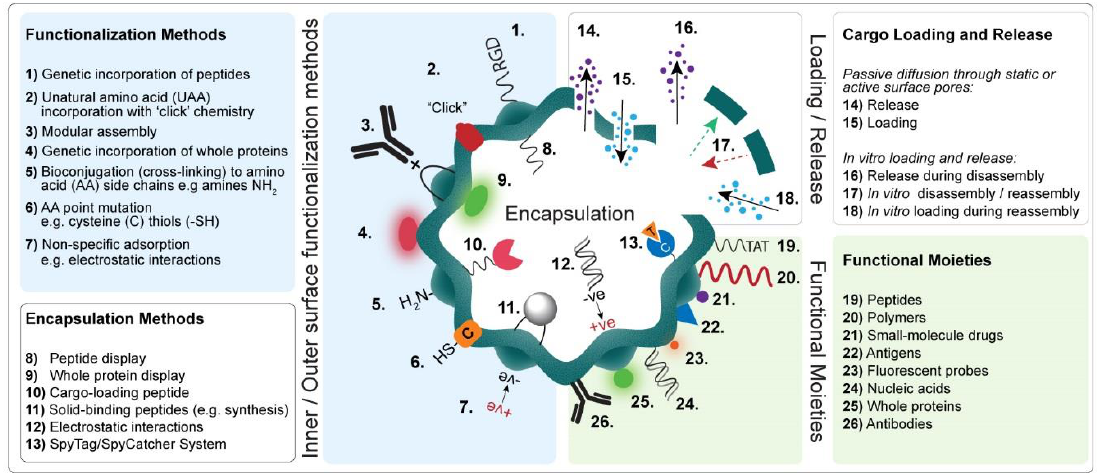
Figure 2. Illustration showing the various approaches used to functionalize PNPs with different functional moieties, and the strategies employed to encapsulate, load, and release cargo molecules. RGD, cell-binding motif (Arg-Gly-Asp); TAT, human immunodeficiency virus (HIV-1) cell-penetrating peptide (CPP); +ve, positive; –ve: negative.